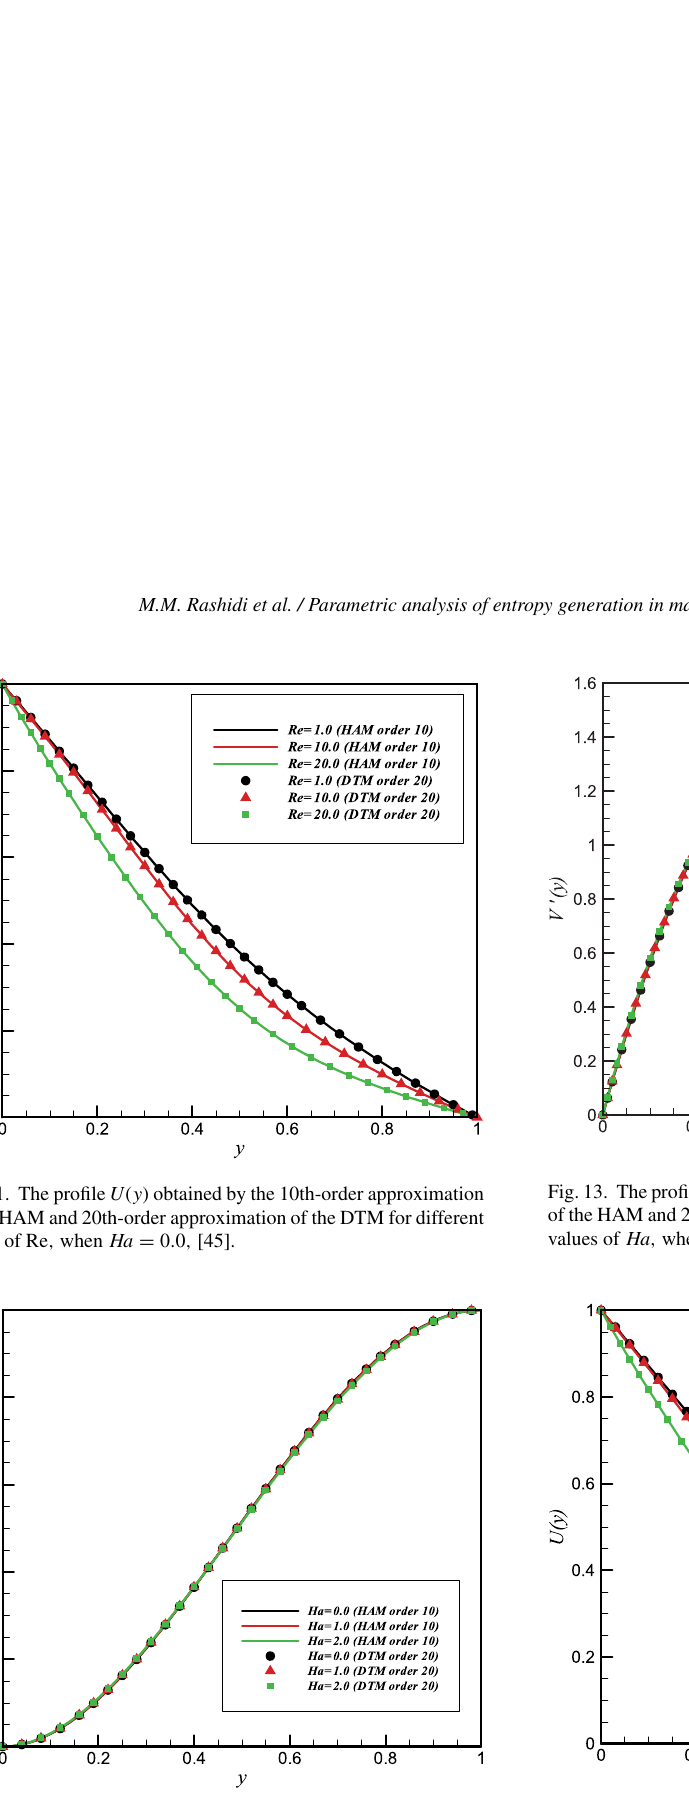
Fig. 12. The profile V ( y ) obtained by the 10th-order approximation of the HAM and 20th-order approximation of the DTM for different values of Ha, when Re = 1 . 0 , [45].